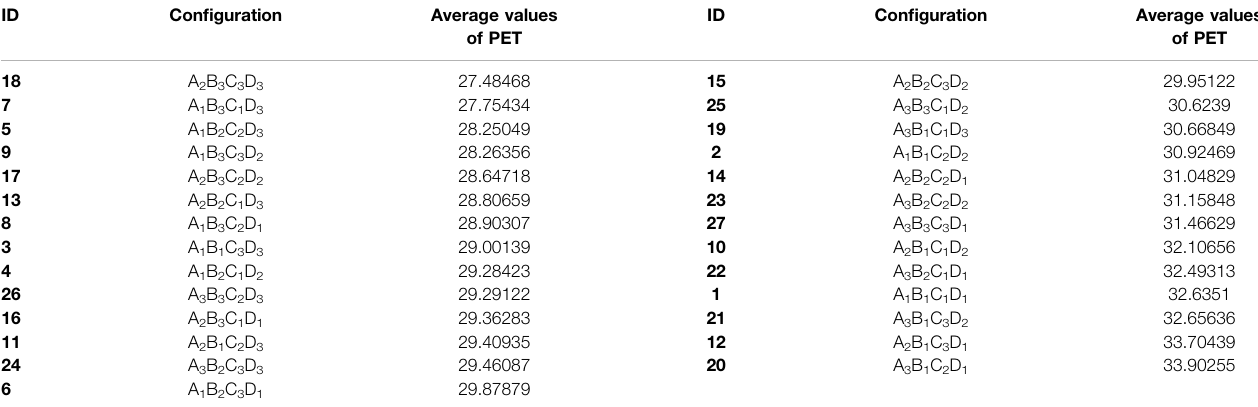
TABLE 9 | Design implications of street geometry. Aspect ratio Diagram Suggested implications Suggested